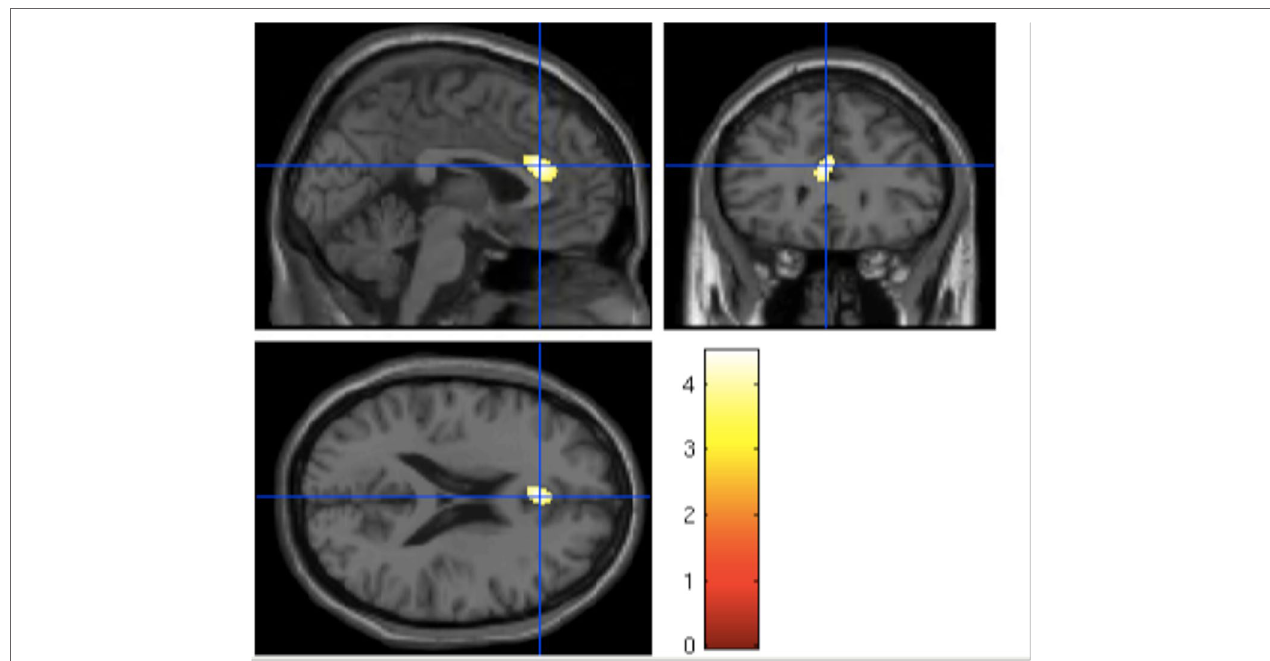
FIGURE 3 | Significant reduction in the anterior cingulate volume in UHR subjects with high EASE scores compared to HC.